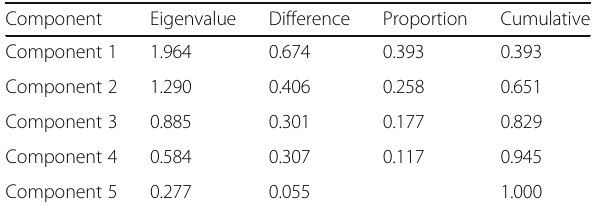
Table 3 Eigenvalues of the components